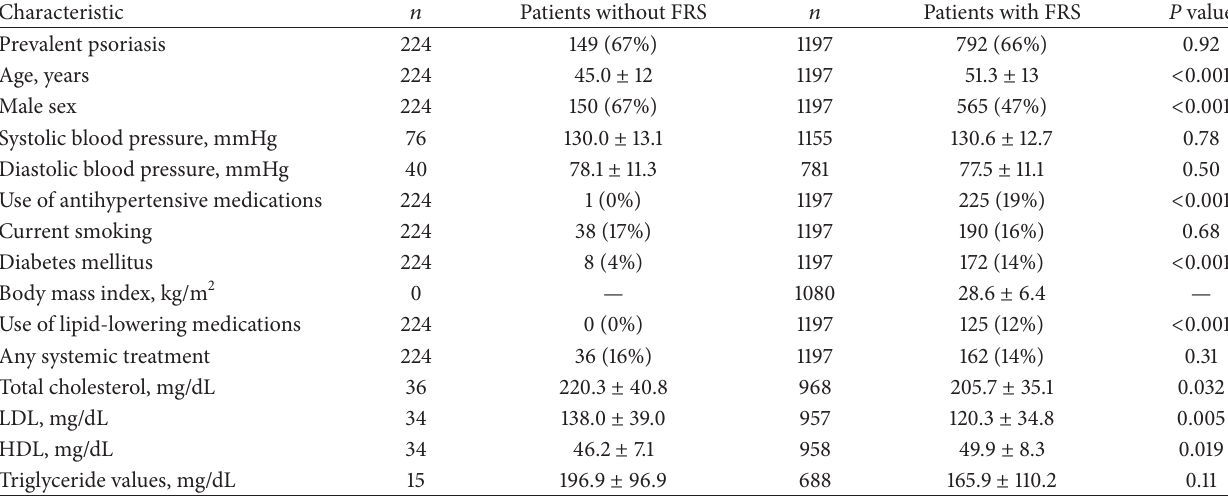
Table 1: Characteristics and cardiovascular risk factors of patients with psoriasis and no prior cardiovascular disease. Comparison of patients with enough information to compute the Framingham risk score (FRS) to those without enough information for the FRS.